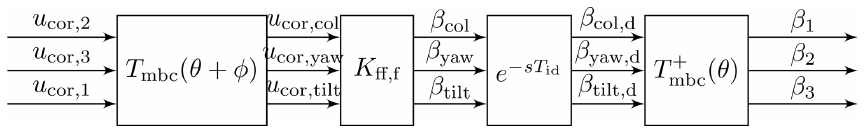
Figure 4. Implementation of the feedforward collective and individual pitch control, where the inputs ( u cor , 1 , u cor , 2 , and u cor , 3 ) are the estimated wind speeds parallel to the rotor shaft axis and the outputs are the blade pitch angles ( β 1 , β 2 , and β 3 ). The feedforward con- troller ( K ff , f ) is implemented in the non-rotating (fixed) frame of reference and is, therefore, denoted with an extra index “f”. Further, the multiblade coordinate transformation ( T mbc ) is applied to the inputs, and the pseudo-inverse transformation ( T +